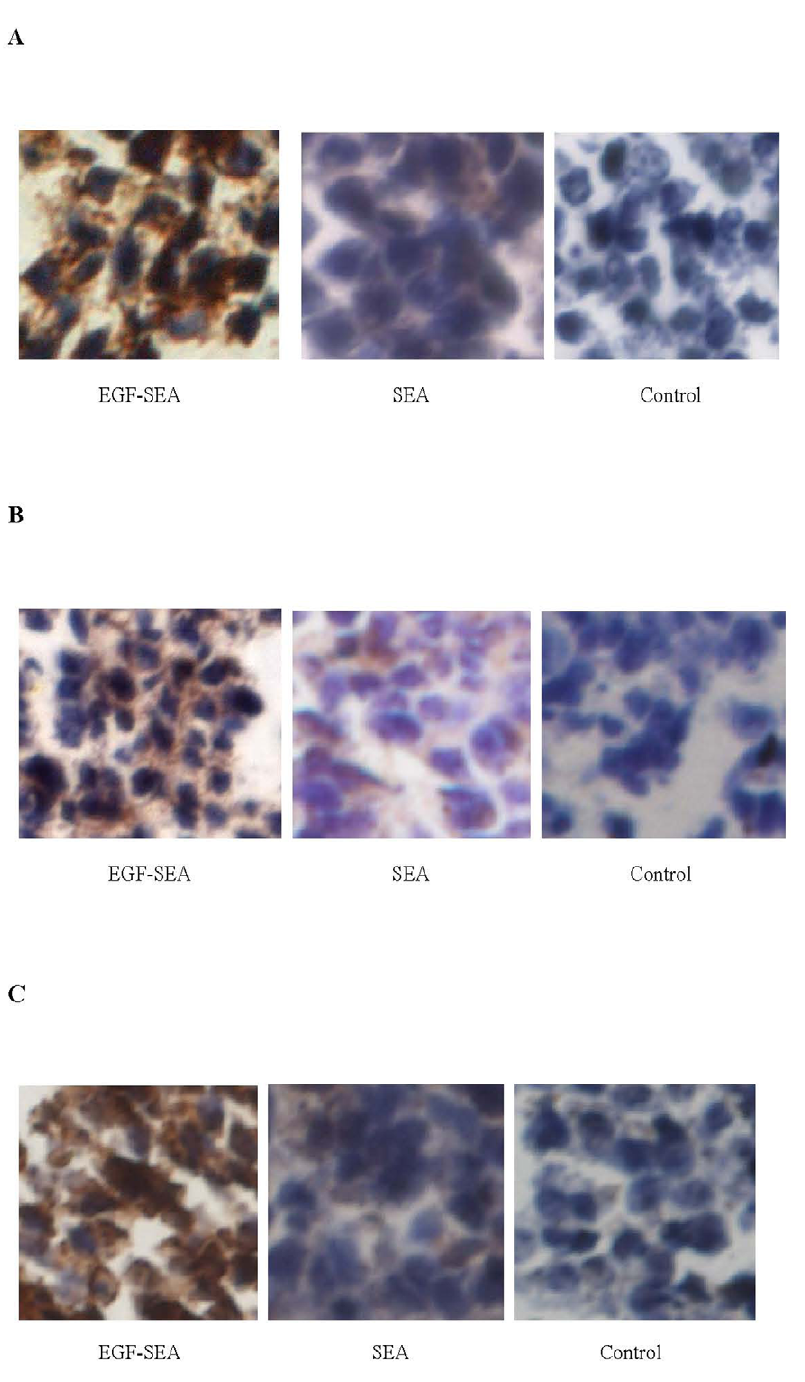
Figure 3. Detection of intratumoral CTLs. Small brown spots around S180 tumor cells indicated antibody-reactive T cells. (A) CD4-positive cells detected by rabbit CD4-specific polyclonal antibody. (B) CD8 positive cells detected by rabbit CD8-specific polyclonal antibody. (C) SEA-reactive T cells. Sections were incubated with a SEA solution, followed by mouse polyclonal anti-SEA IgG fraction and anti-mouse secondary antibody. Microscope magnification: 6 400 in A to C.